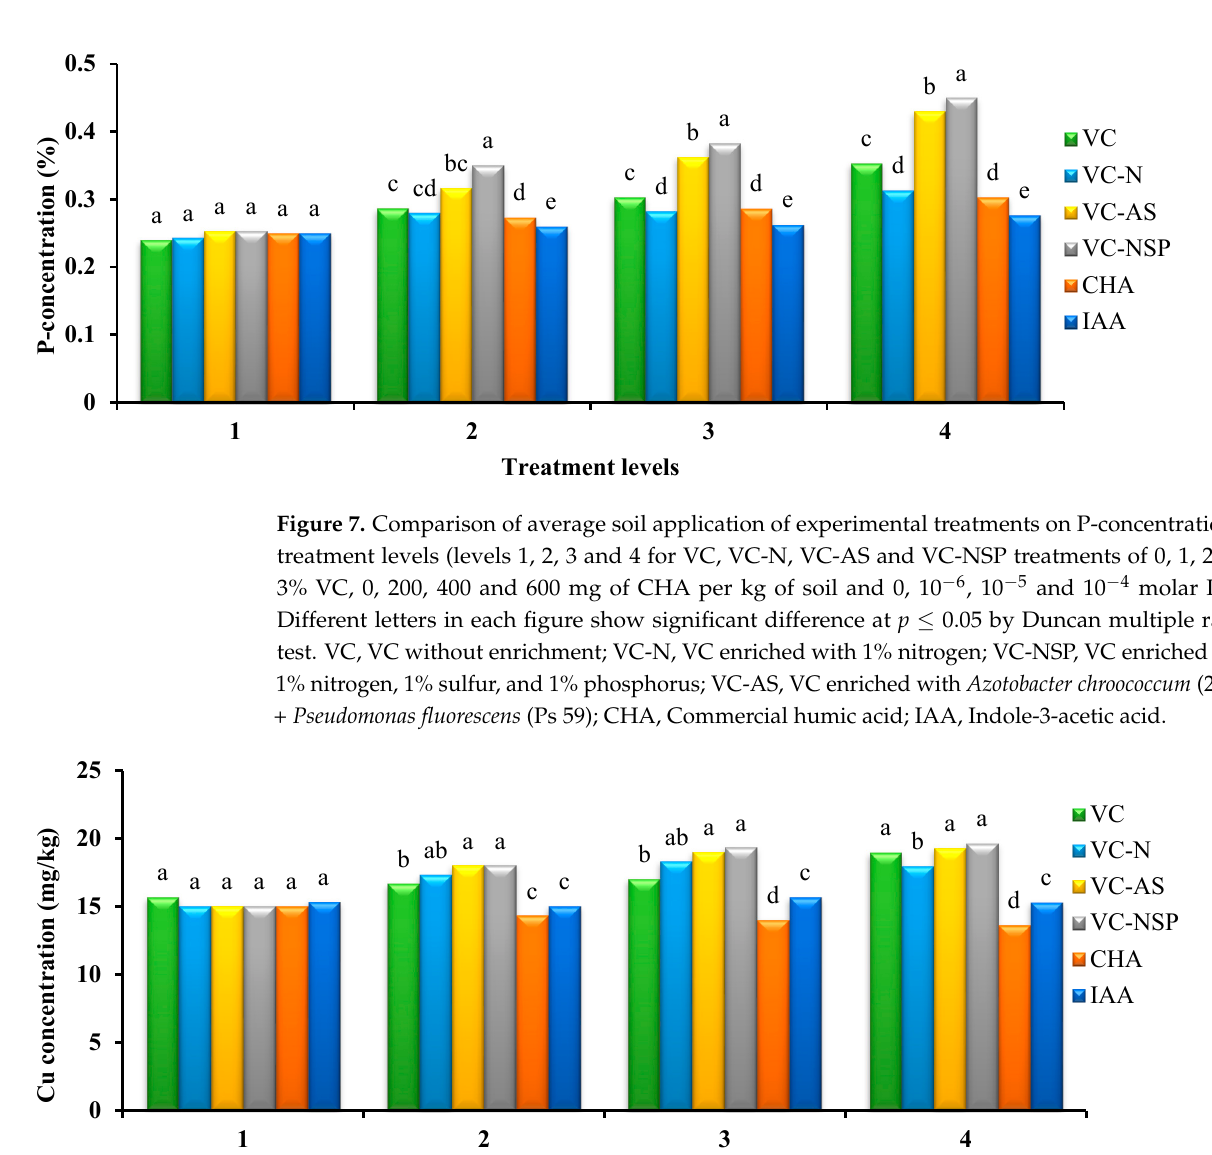
15 of 20 Figure 6. Comparison of average soil application of experimental treatments on seed oils at different treatments. Different letters in each figure show significant difference at p ≤ 0.05 by Duncan multiple range test. VC, VC without enrichment; VC-N, VC enriched with 1% nitrogen; VC-NSP, VC enriched with 1% nitrogen, 1% sulfur, and 1% phosphorus; VC-AS, VC enriched with Azotobacter chroococcum (21Az) + Pseudomonas fluorescens (Ps 59); CHA, Commercial humic acid; IAA, Indole-3-acetic acid. 3.4. Effect of Using Different Treatments on Nutrients Concentrations in the Aerial Organ of Rapeseed 3.4.1. Phosphorus The results of variance analysis of phosphorus content measured in rapeseed branches at the end of harvest showed a significant statistical difference between various levels of treatments and different treatments. The highest and lowest amounts of phos- phorus were obtained from the applications of 3% VC-NSP (0.45%) and indole-3-acetic acid, respectively (Figure 7). Increasing the concentration and consumption percentage of treatments increased the amounts of phosphorus in treatments. Ebrahimi et al. [79] showed that as an organic source, VC enhances access to nutrients including phosphorus,